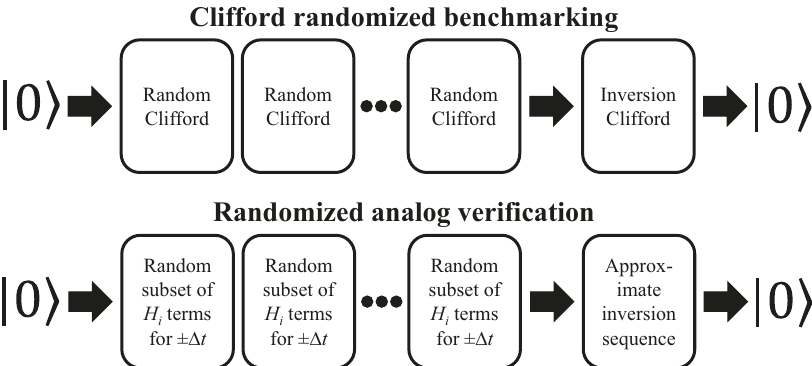
Fig. 2 High-level comparison of traditional randomized benchmarking and the randomized analog veri fi cation protocol. Both protocols involve generating a sequence that starts and ends in a known basis state, which is denoted 0 j i in this fi gure for simplicity, and proceed by simply making a series of random choices. For traditional RB, the inversion Clifford is calculated deterministically based on the preceding sequence of random Cliffords. For randomized analog veri fi cation, the inversion sequence is compiled approximately via a stochastic search